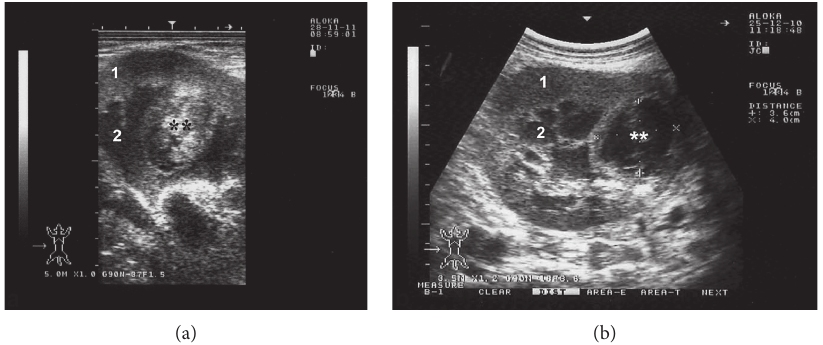
Figure 18: Transabdominal ultrasonographic examination of renal masses ( ∗ ∗ ) in 2 camels. Image (a) with echogenic mass was captured transrectally from the left kidney. Image (b) with hypoechoic mass in the right kidney was taken transcutaneously from the upper right paralumbar fossa. Both masses were confirmed to be abscesses through ultrasound-guided aspiration of pus. 1, cortex; 2, medulla.